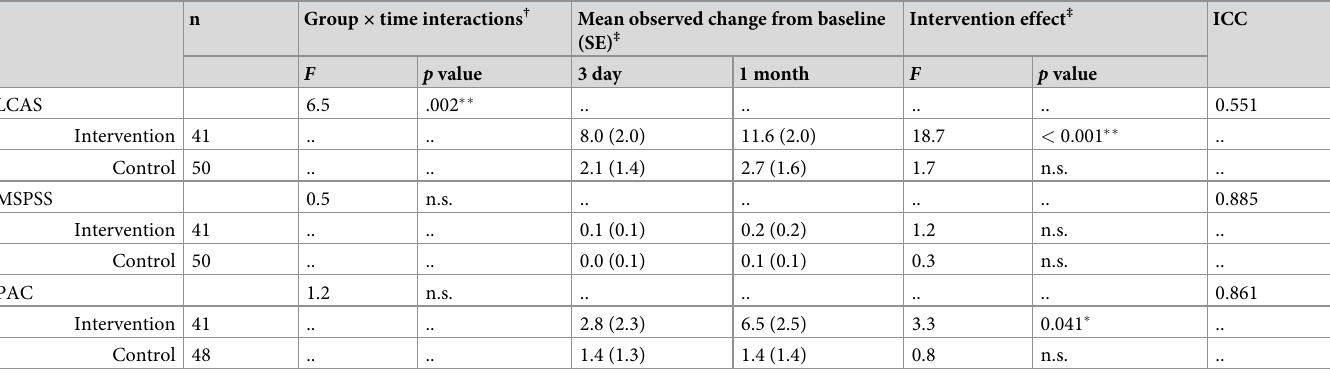
Table 2. Changes in the outcome measures for the intervention and control